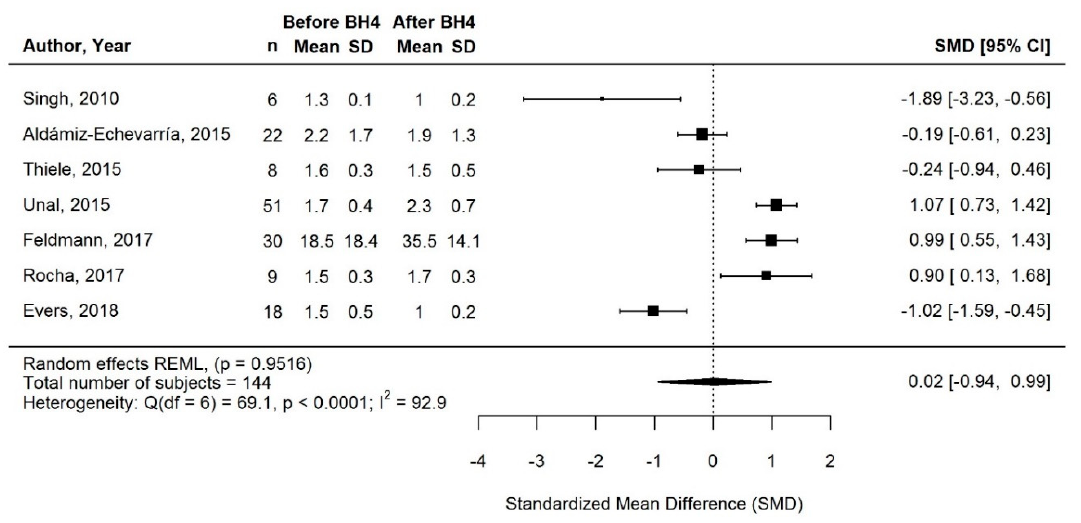
Figure 5. Standardized change in total protein intake of long-term responders on BH4 treatment. Means and SDs before/after BH4 are gram total protein per day for Feldmann (2017), and gram per kilogram per day for all other studies. Abbreviations: BH4, tetrahydrobiopterin; CI: confidence interval; n: sample size; SD: standard deviation; SMD, standardized mean difference.